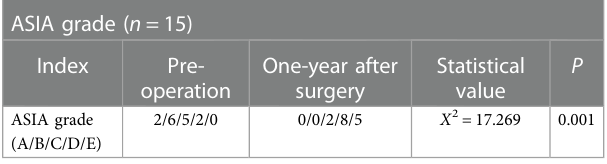
TABLE 2 Comparison of patients ’ ASIA grade between pre-operation and 1-year after surgery. ASIA grade ( n = 15)